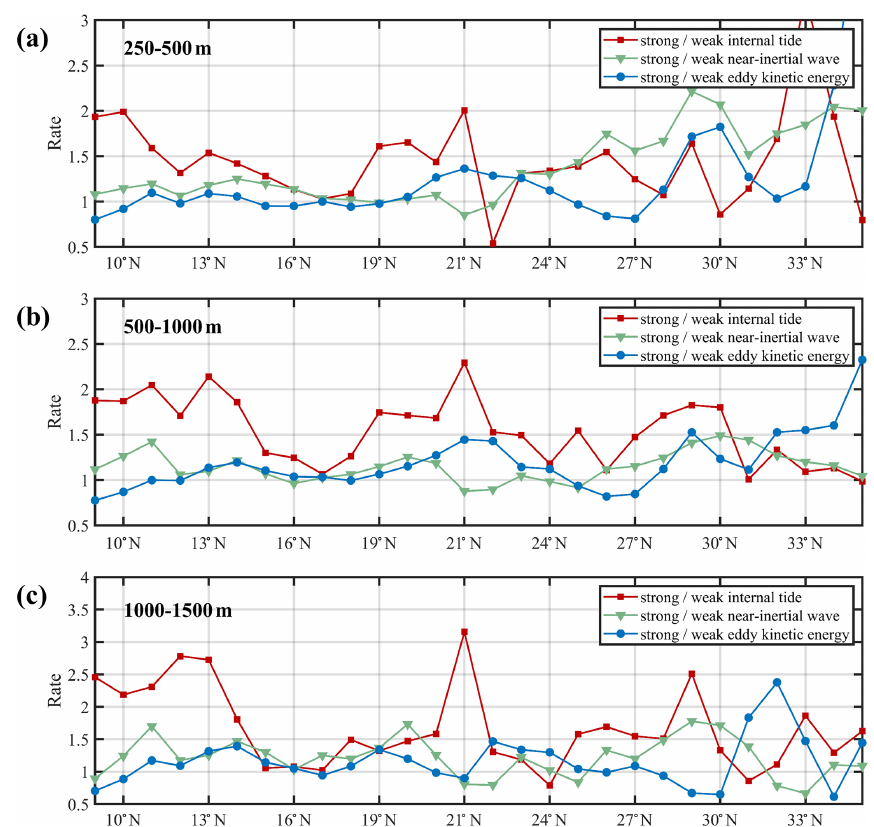
Figure 4. Ratios of diapycnal diffusivities between areas over strong (greater than median) and weak internal tides (red lines), strong (greater than median) and weak near-inertial waves (green lines), and strong (greater than median) and weak EKE (blue lines) for each 1 ◦ latitude band in the depth ranges of (a) 250–500m, (b) 500–1000m, and (c) 1000–1500m, which show averages for each band containing more than 10